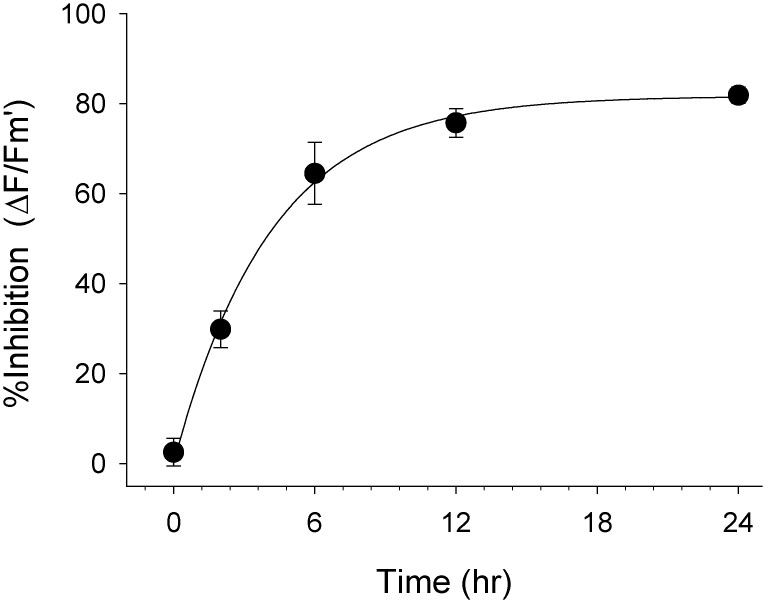
Time taken to reach steady state toxicity.Inhibition of effective quantum yield (ΔF/F
m’) in H. ovalis by 10 μg l-1 Diuron relative to solvent control conditions versus time. Bars ± SE, n = 16.